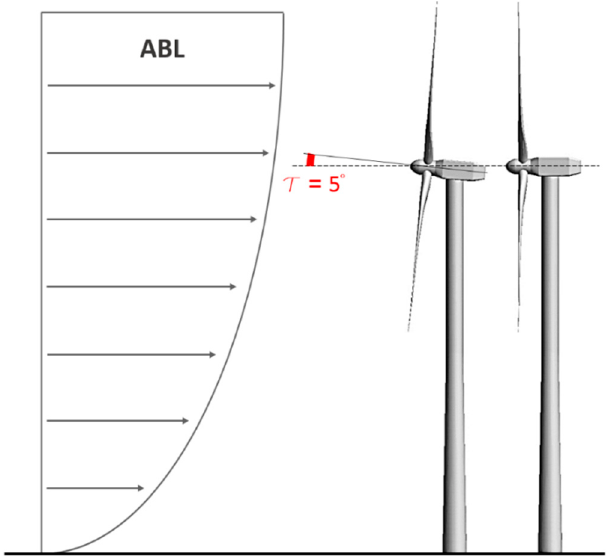
Figure 3. ( left ) Full machine tilted configuration and ( right ) untilted configuration with indication of the imposed atmospheric boundary layer (ABL).